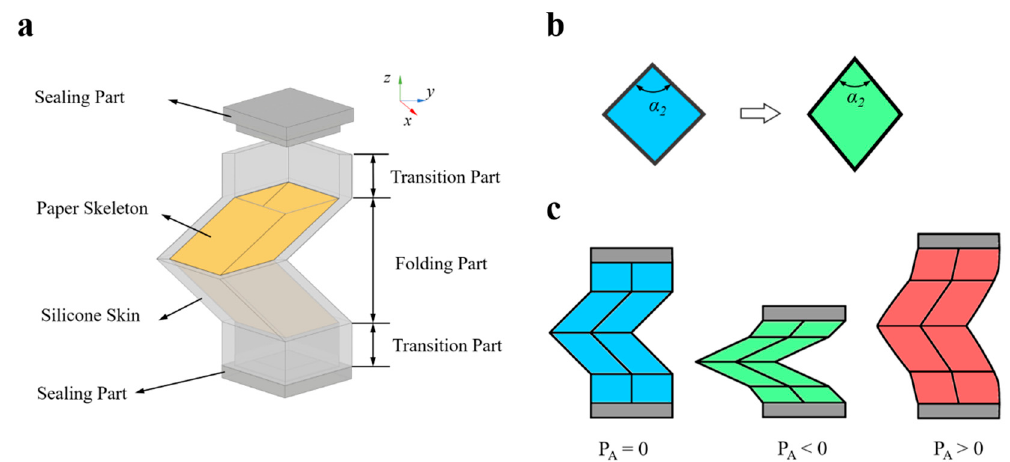
Figure 2. The Pneumatic foldable actuator(PFA). ( a ) The PFA is composed of a sealing part, transition part, and folding part; ( b ) In the folding process of the foldable part, the cross-section of the foldable part parallel to the y - z plane will change from a square to a parallelogram; ( c ) Deformation of the PFA under di ff erent states: the initial state of the PFA ( P A = 0); the folding state, the PFA reduces its length under negative pressure ( P A < 0); the inflation state, the PFA extends its length under positive pressure ( P A > 0).